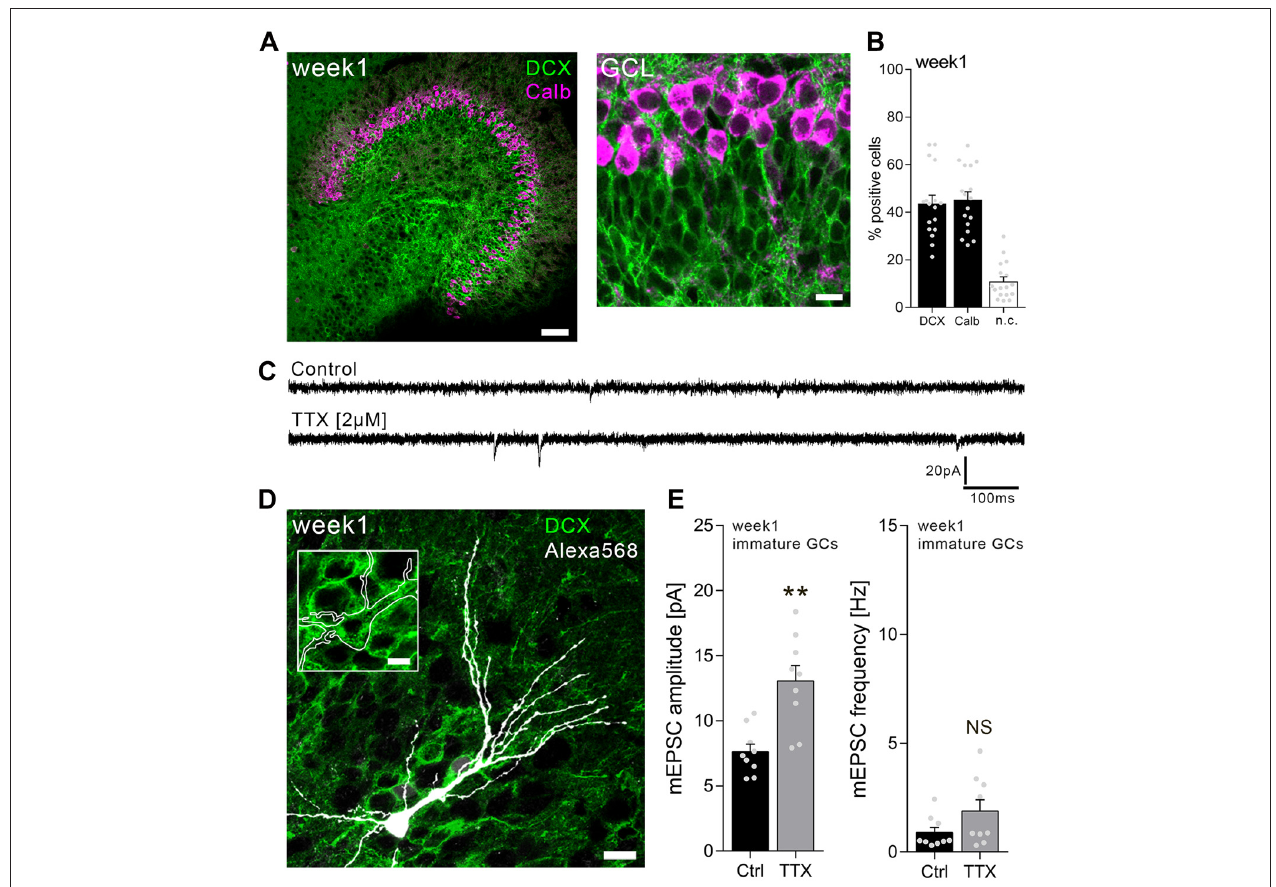
FIGURE 1 | Immature dentate granule cells (GCs) of 1-week-old slice cultures express homeostatic excitatory synaptic plasticity. (A) Example of a 1-week-old entorhino-hippocampal slice culture stained for calbindin (Calb, magenta) and doublecortin (DCX, green). The GC layer (GCL) is shown at higher magnification. Scale bars, 50 µ m and 10 µ m. (B) Quantification of DCX and Calb expression in 1-week-old slice cultures. Some cells expressed both or neither of the markers (n.c., not classified; n = 17 cultures per group). (C) Sample traces of α -amino-3-hydroxy-5-methyl-4-isoxazolepropionic acid (AMPA) receptor-mediated miniature excitatory postsynaptic currents (mEPSCs) recorded from immature GCs in tetrodotoxin TTX (2 µ M, 3 days) and vehicle-only (control)-treated cultures. (D) Example of a recorded (biocytin-filled), post hoc identified (streptavidin-Alexa568, white) immature GC in a DCX-stained slice culture. Scale bars, 10 µ m and 5 µ m (inset). (E) Group data of mEPSC recordings (amplitudes and frequencies) from immature GCs of vehicle-only-(Ctrl, control) and TTX-treated cultures ( n control = 9 cells,